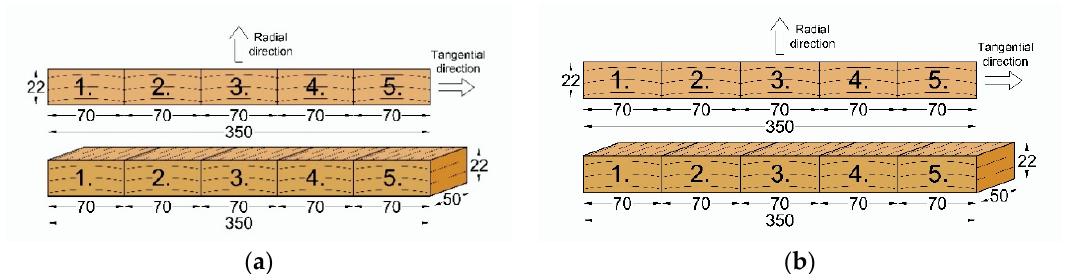
Figure 4. Geometry of the specimens used to assess the quality of the bond line. ( a ) Surface bonding and ( b ) edge bonding (dimensions in mm).